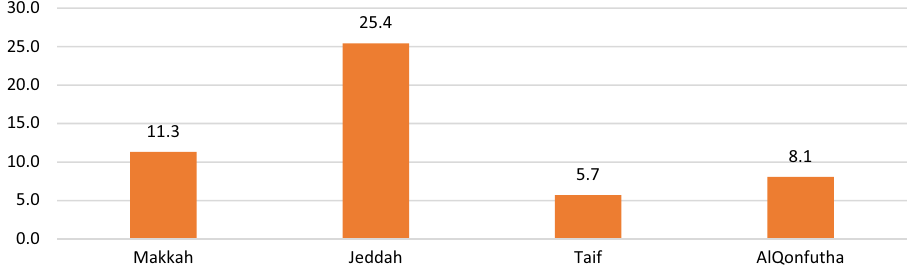
Figure 1. Incidence rate of TB infection per 100,000 in cities of Makkah region 2016.